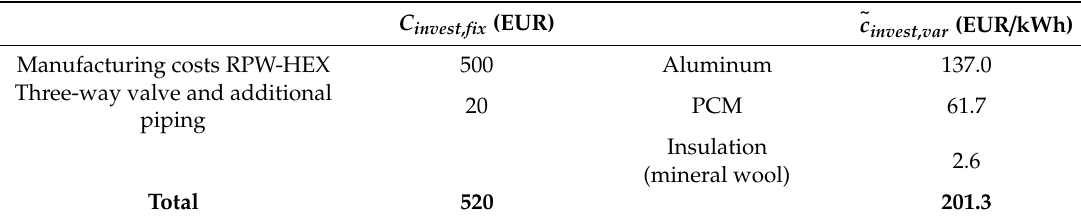
Table 2. Constant and variable investment